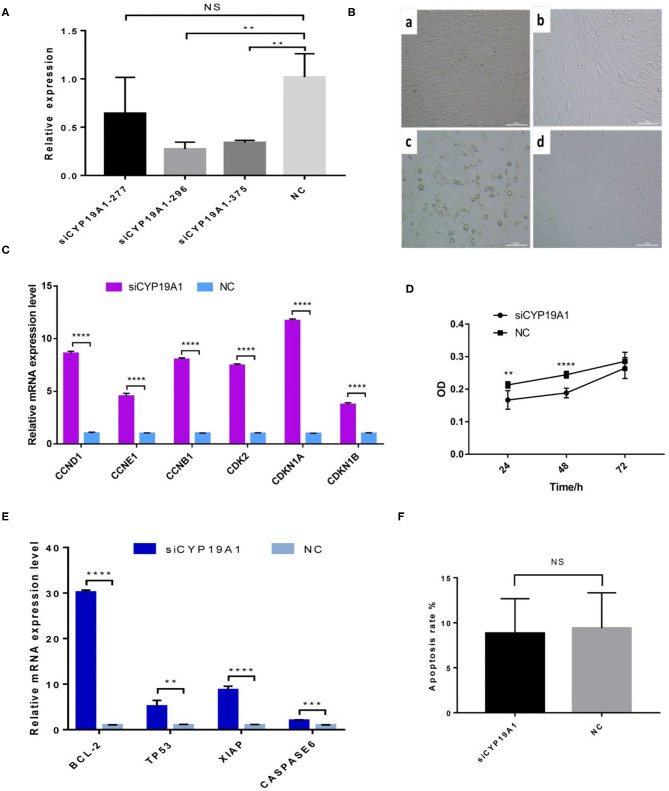
CYP19A1 induced cell proliferation and apoptosis of BFGCs. (A) A screen of CYP19A1 siRNA fragments in BFGCs. (B) Changes of cell morphology after CYP19A1 interference for 72 h. 200 × (bar = 100 μm). Note a: BFGCs transfected with siCYP19A1-277 for 72 h; b: BFGCs transfected with siCYP19A1-296 for 72 h; c: BFGCs transfected with siCYP19A1-375 for 72 h; d: BFGCs transfected with NC for 72 h. (C) Effect of CYP19A1 gene interference on proliferation-related genes expression. (D) Effect of siCYP19A1 on BFGCs by CCK-8 cck8 detection. (E) Effect of CYP19A1 gene interference on apoptosis-related genes expression. (F) Comparison of apoptosis rates between test group and native control group. **P < 0.01; ***P < 0.001; ****P < 0.0001; NS, no significant.